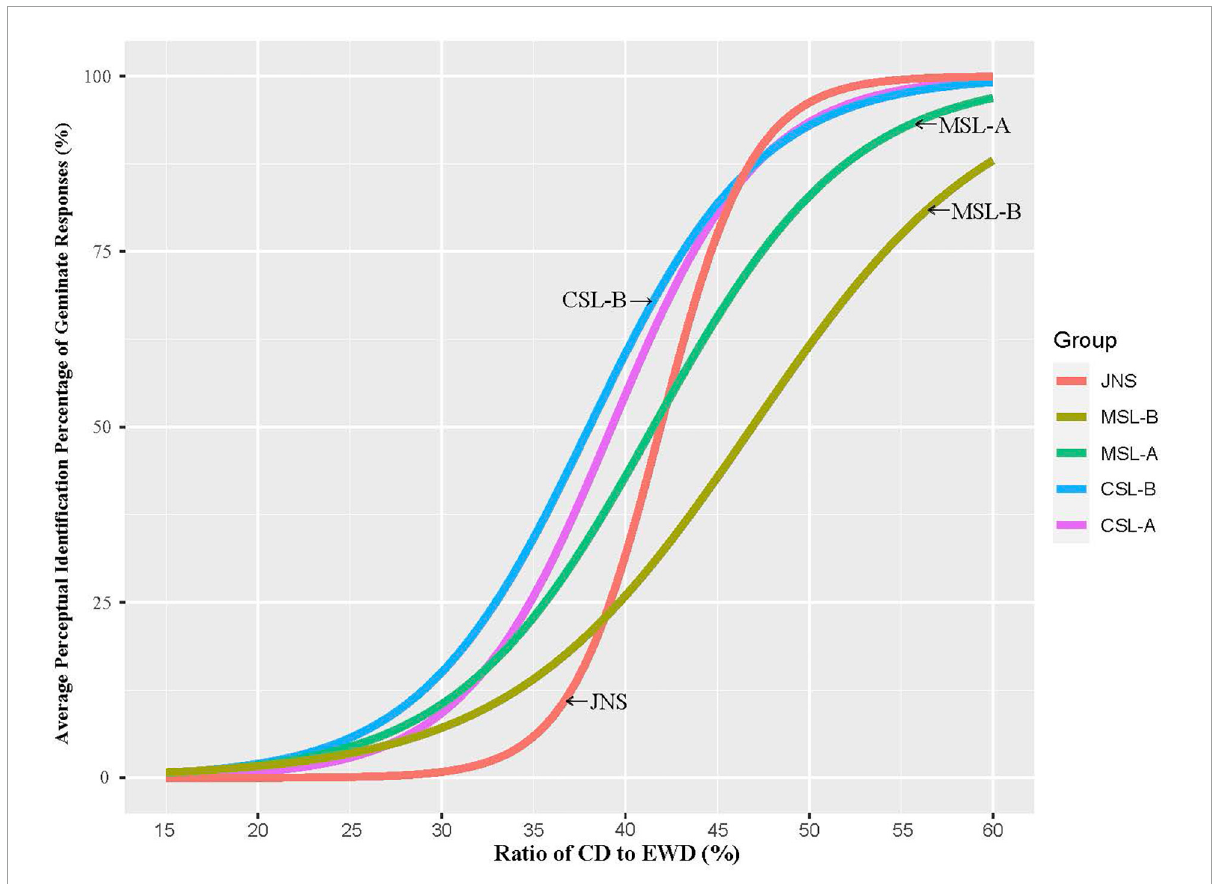
FIGURE2 Approximate curves of logistic regression models to the average percentage of geminate (‘S’)